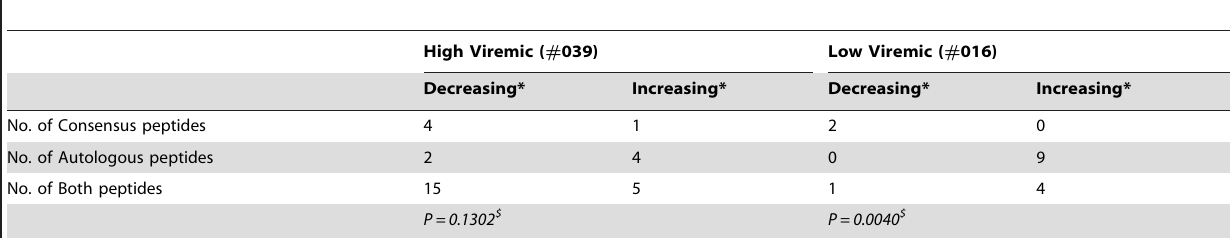
Table 2. Comparison of the trend of increase or decrease of CD8 + IFN- c + response to autologous and clade-B consensus HIV-1 Nef peptides in the two